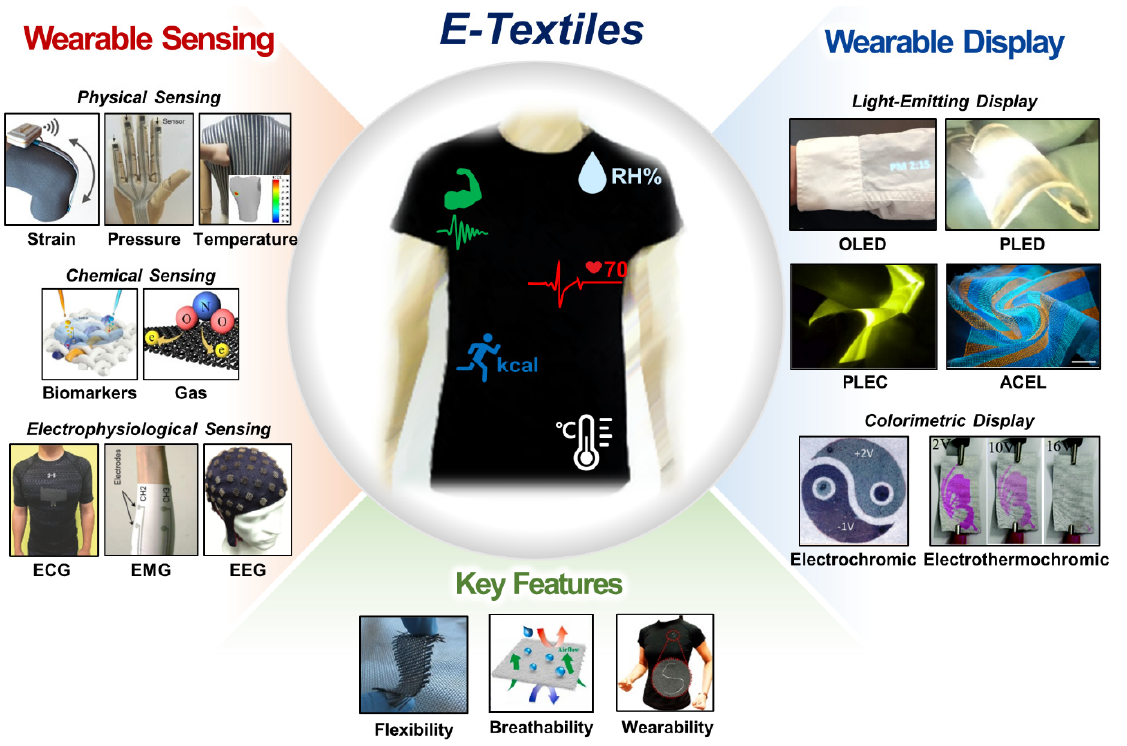
Figure 1. E-textiles for wearable sensing and display. Physical sensing—strain: reprinted with per- mission from [25]. Copyright 2015 American Chemical Society. Pressure: reprinted with permission from [26]. Copyright 2017 Wiley-VCH. Temperature: reprinted with permission from [27].